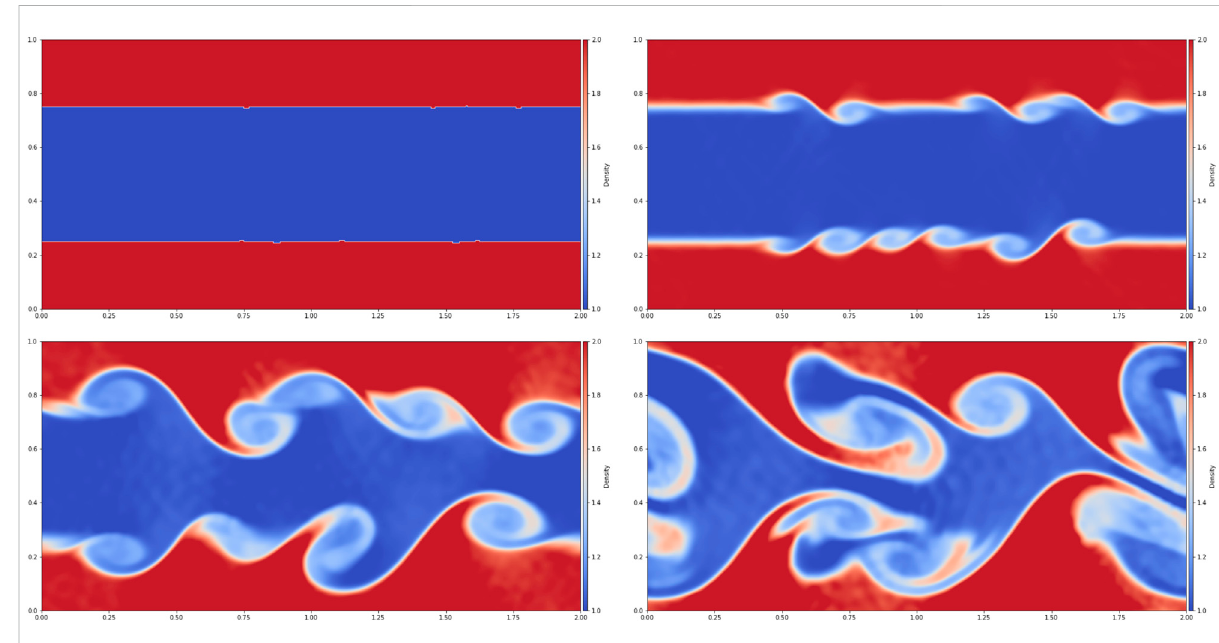
FIGURE 5 A simulation of the Kelvin-Helmholtz instability. The four panels show density in the initial conditions and after 1, 2 and 3 s of simulation time. See animation at